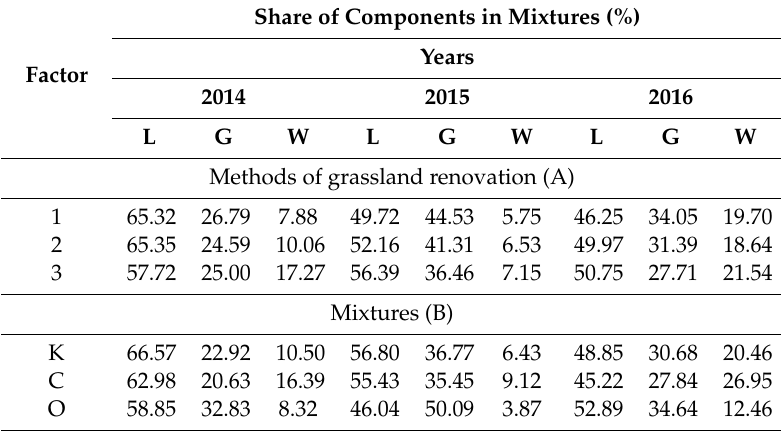
Table 2. Share of components in the dry matter yield of legume–grass mixtures depending on the method of sward renovation and of the species composition mixture in 2014–2016 (%).